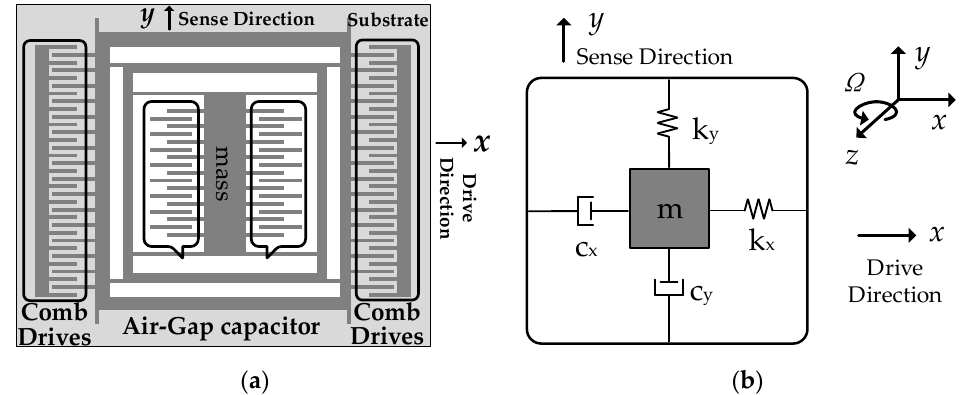
ω . When d ω . When d